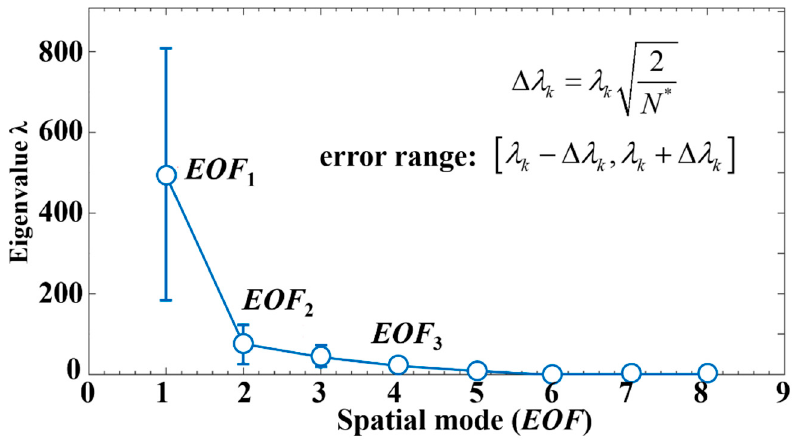
Figure 11. Eigenvalues of each empirical orthogonal function ( EOF ) mode at 95% confidence level.